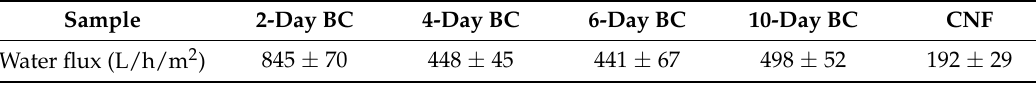
Table 2. Water flux values for filtering 300 mL of pure water by CNF membrane and BC membranes harvested after different